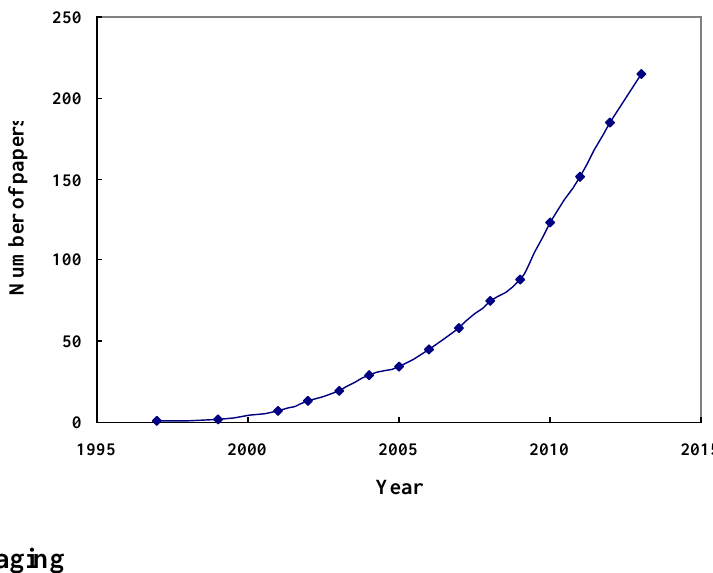
Figure 1. The number of publications about hyperspectral imaging applications in